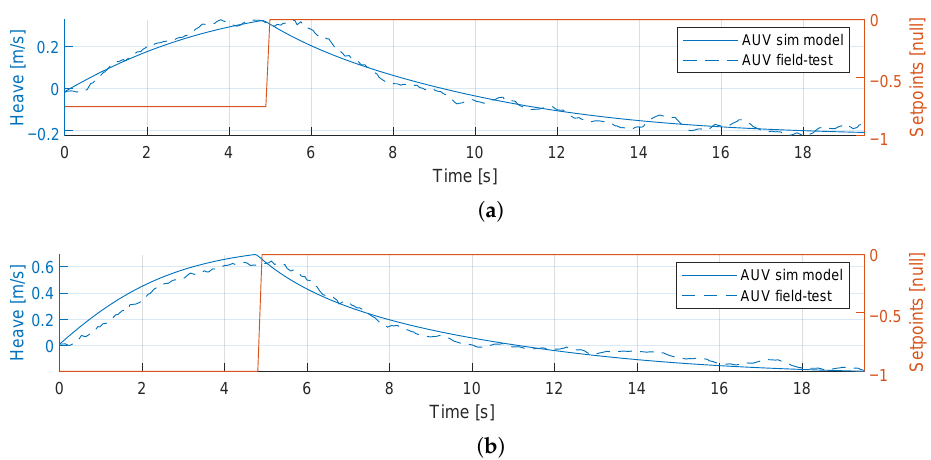
Figure 6. Model-validation using parameter estimation for the Girona500: ( a ) Heave motion (thruster setpoints equal to − 0.75), ( b ) Heave motion (thruster setpoints equal to −